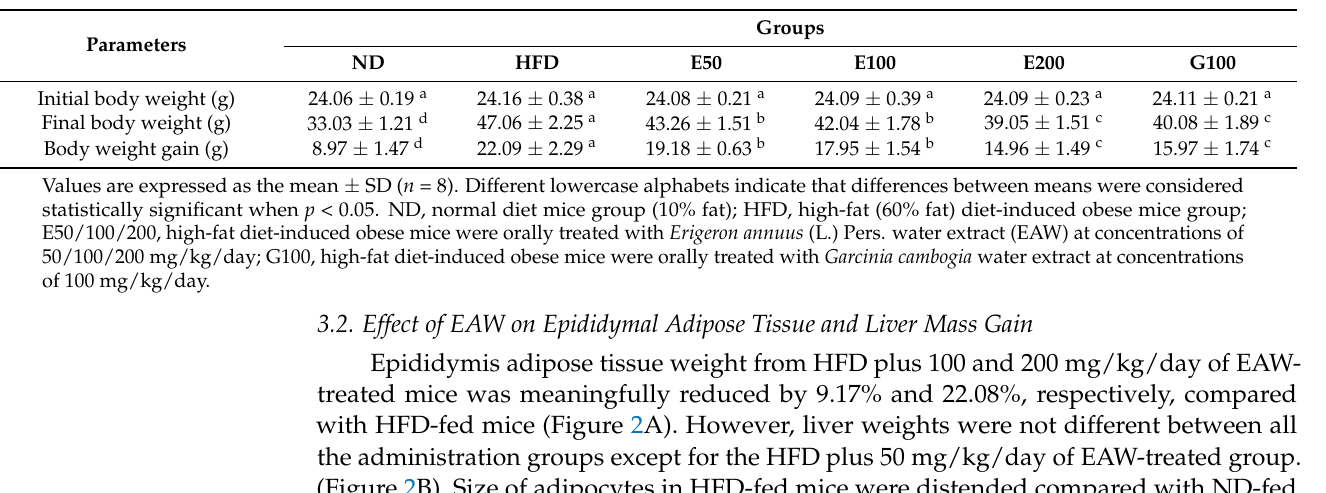
Table 2. Effect of EAW in HFD-induced obese mice on body